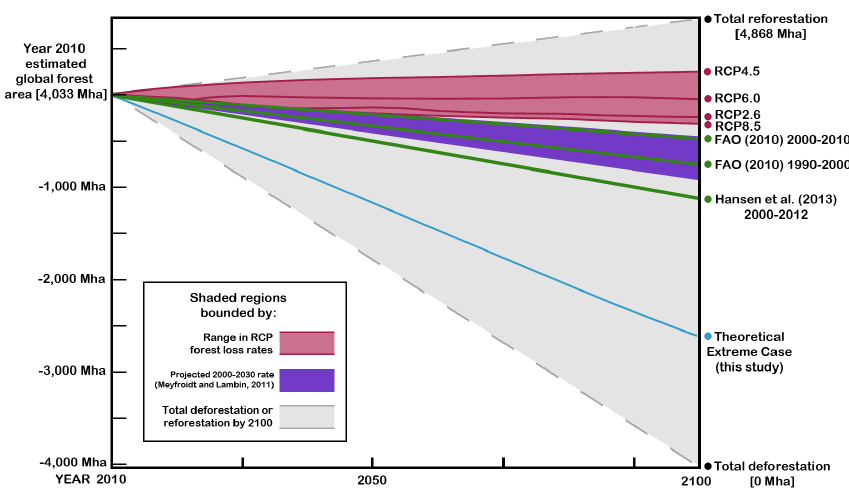
Figure 5. Comparison of projected annual rates of forest area change. Colored lines and shading represent the change in global forest area between 2010 and 2100 for the Representative Concentration Pathways (red) and the theoretical extreme case (light blue). The grey shaded region is bounded by the annual rate of forest area change required to completely reforest to the estimated prehistoric forest area (Pongratz et al., 2008), or remove all forests by year 2100. Reported and projected forest area change from Meyfroidt and Lambin (2011) (purple) and FAO (2010) and Hansen et al. (2013) (green) are depicted as constant rates through year 2100 to show the result if these rates were sustained. Table 5. Enhancement of CO 2 RF by other forcing agents for LULCC and non-LULCC activities. RFs are given in units of Wm − 2